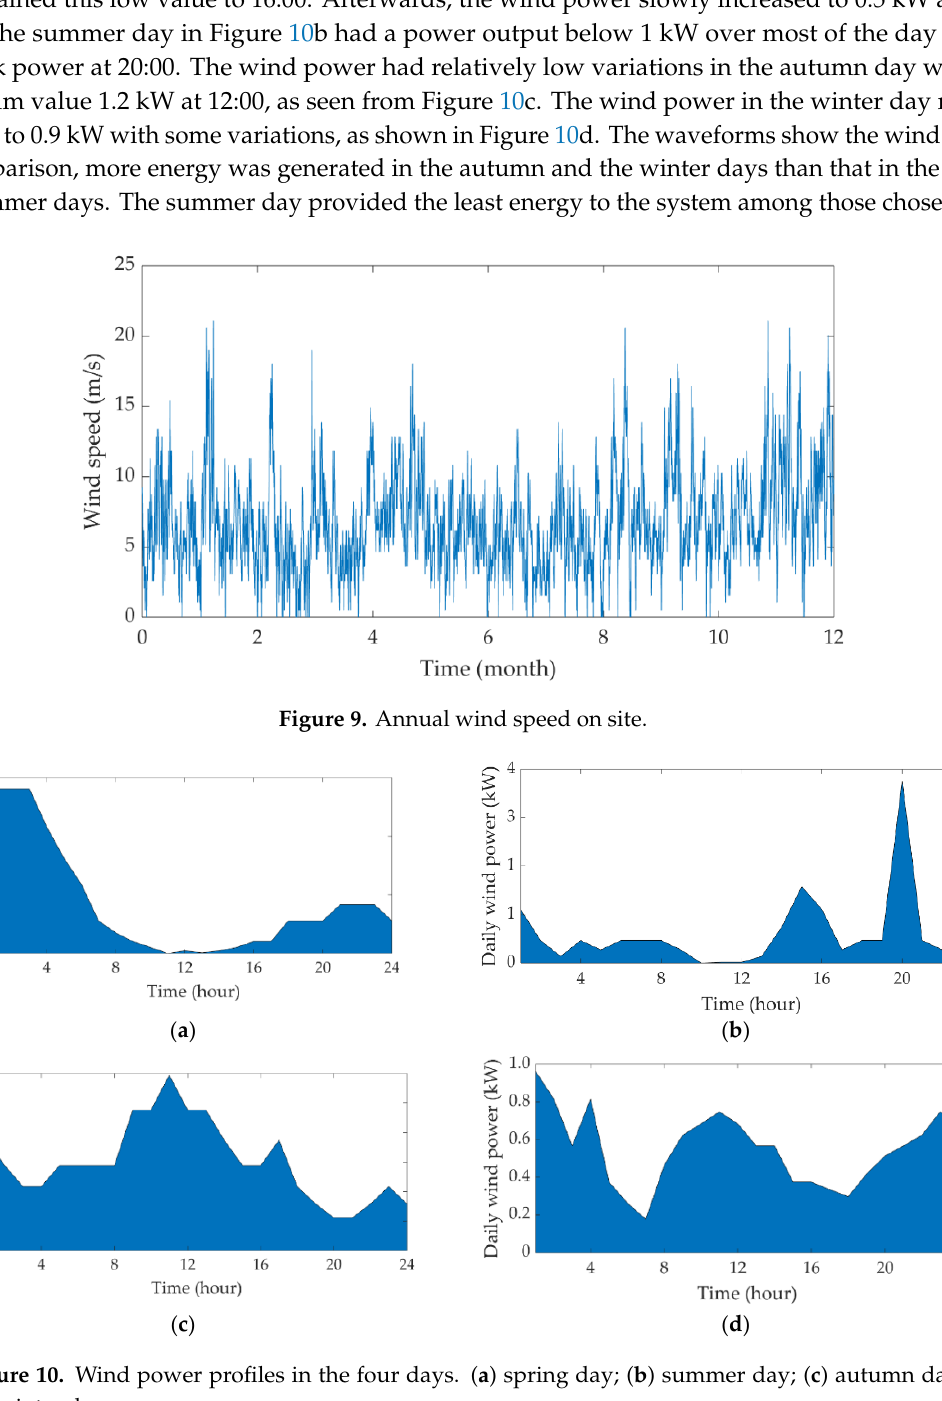
Figure 10. Wind power profiles in the four days. ( a ) spring day; ( b ) summer day; ( c ) autumn day; ( d ) winter day.